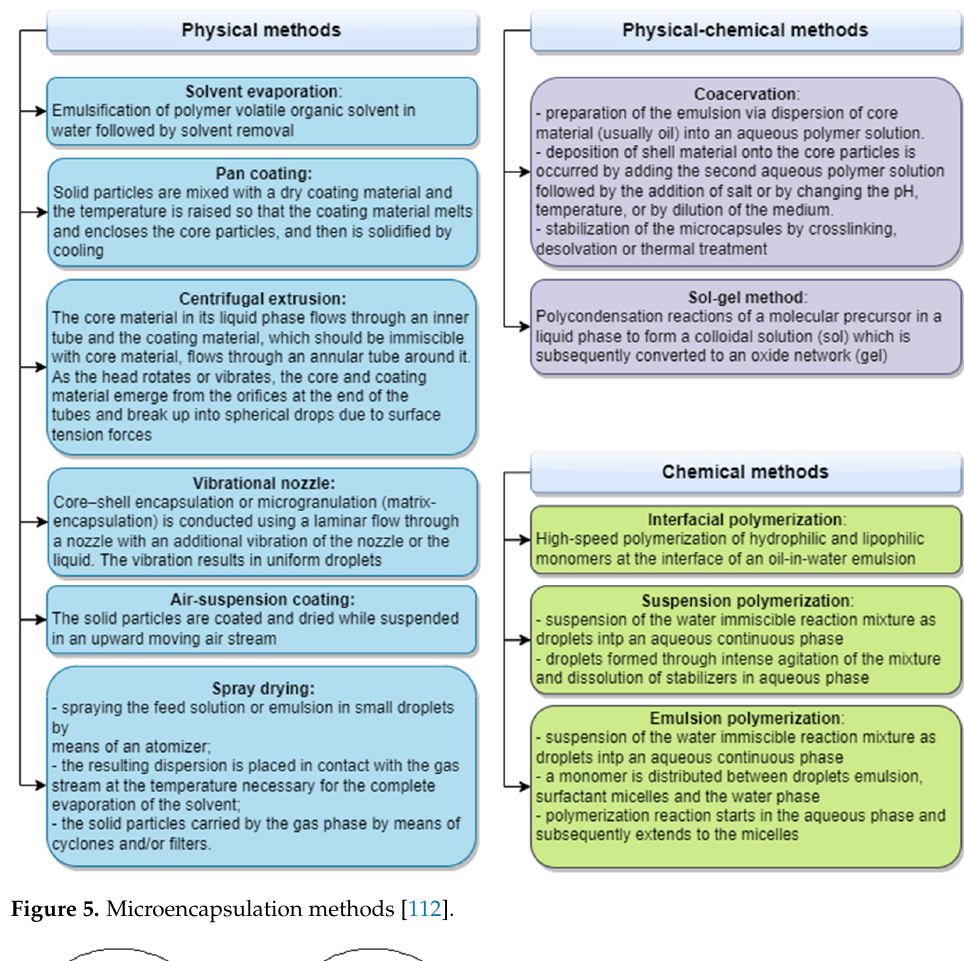
Figure 6. Microcapsule types, Jamekhorshid [112].